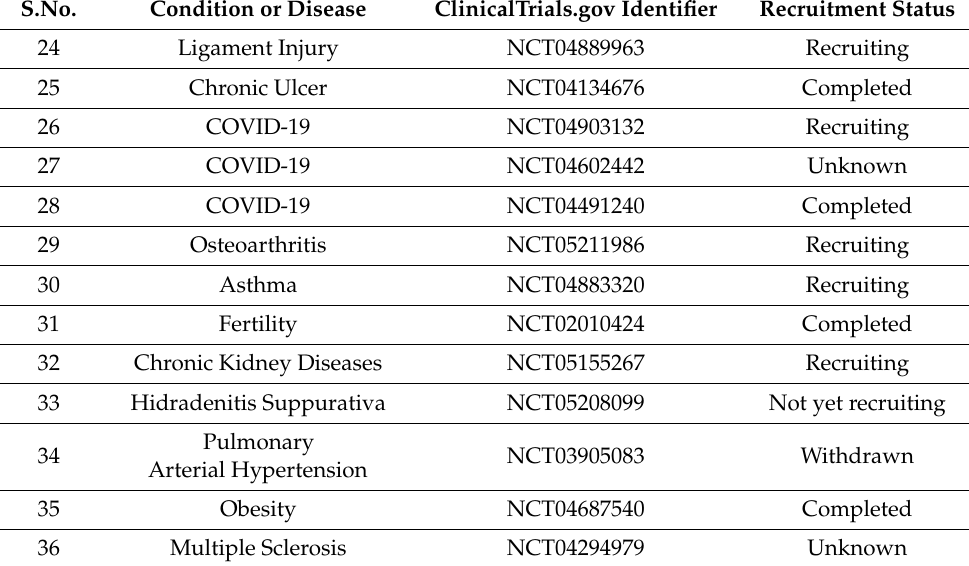
Table 1. Cont. S.No.